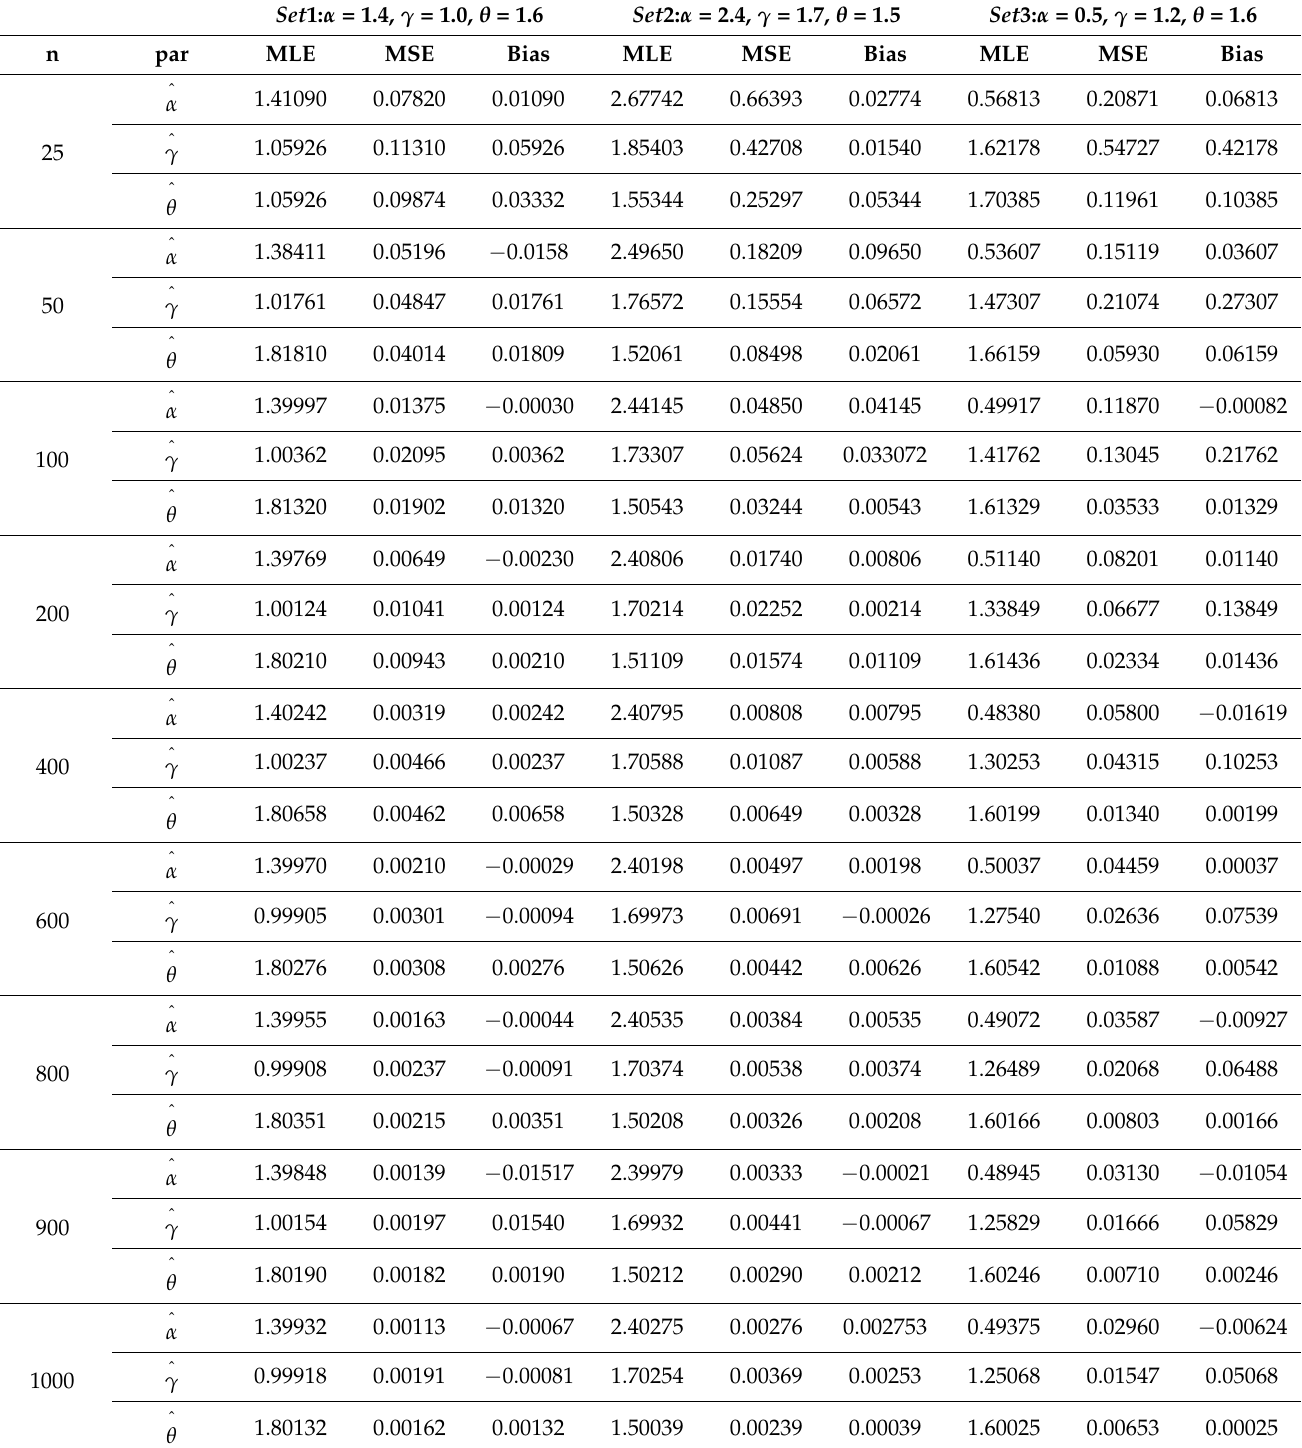
Table 1. Simulation results for NMEPA-Wei distribution of MLEs, MSEs, and Biases for Set 1, Set 2, and Set